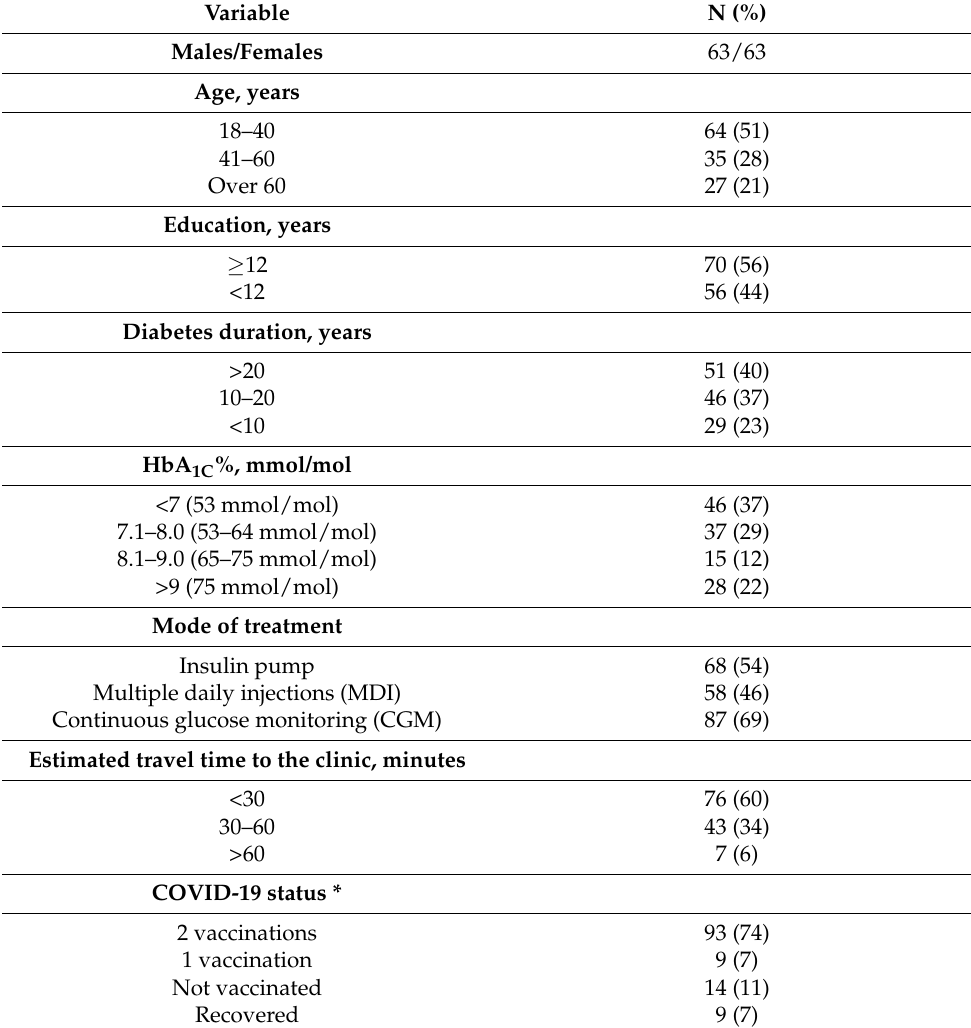
Table 1. Baseline characteristics of the study population (N =